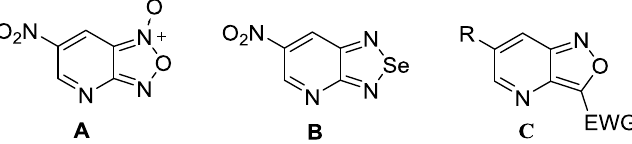
Figure 2. Pyridines fused with high-electrophilic heterocycles.